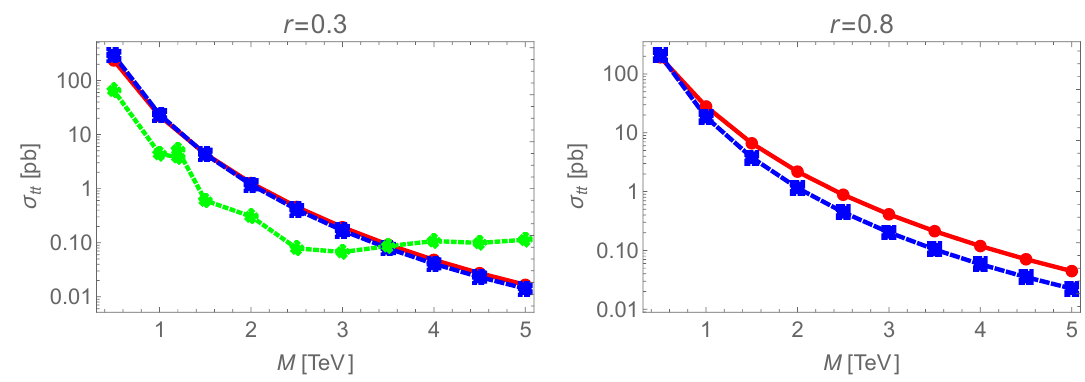
Figure 5 . pp → G ∗ → t ¯ t integrated cross-section as a function of the renormalized on-shell mass M for the ratio r = 0 . 3 (left panel) and r = 0 . 8 (right panel) . The red solid lines correspond to the full propagator, the blue dashed lines to the BW propagator with on-shell parameters, and the green dotted line to the experimental 95% CL upper limit observed by the ATLAS collaboration